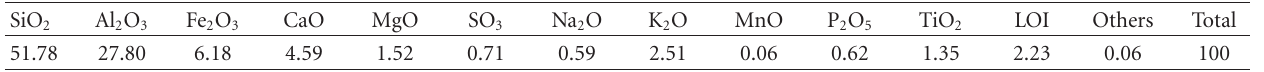
Figure 2: Nyquist plots for low-nickel SS in Ca(OH) 2 -saturated solution with di ff erent NaCl concentrations: (a) 0.0, 0.4, 1.0%, and (b) 2.0, 3.0, 5.0%. Table 2: Chemical composition of the tested fly ash (% in